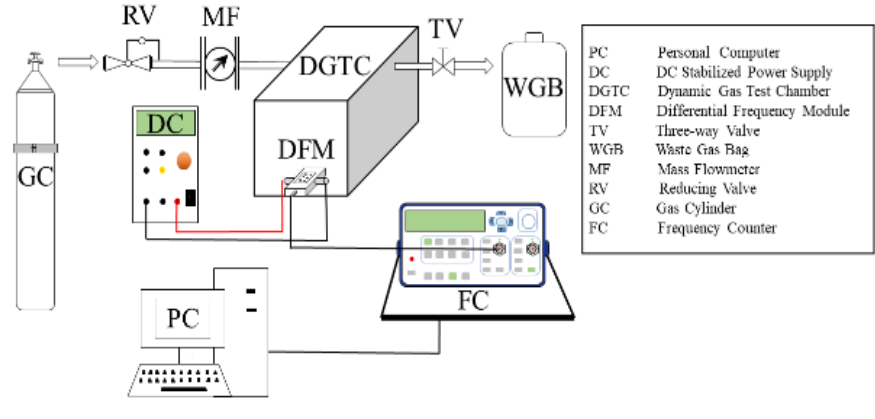
Figure 9. Gas-sensitive test system.